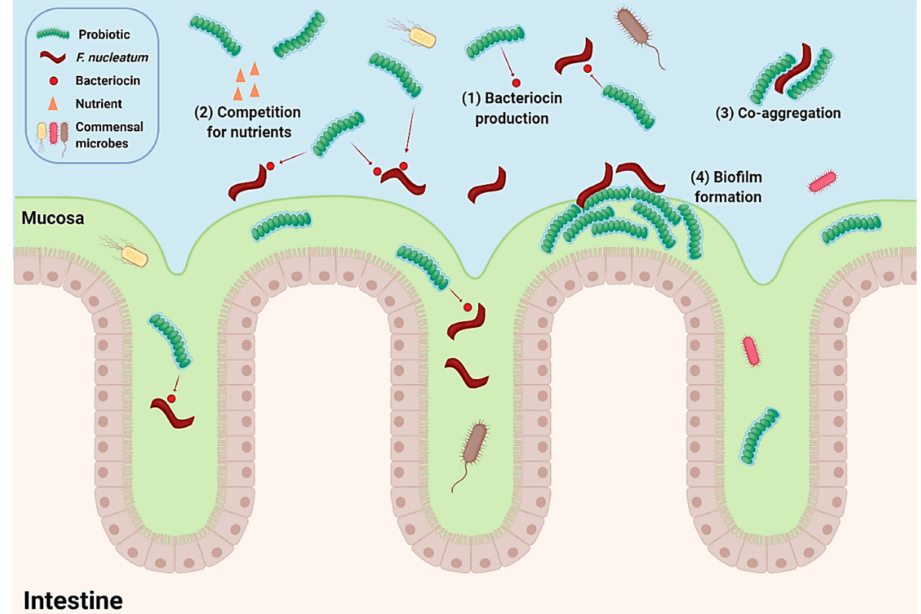
Figure 2. Proposed mechanism of action by which probiotic supplementation may decrease the risk of developing colon cancer by inhibiting F. nucleatum through (1) bacteriocin production, (2) competition for nutrients, (3) co-aggregation, and (4) competitive exclusion through biofilm formation. This figure was Created with